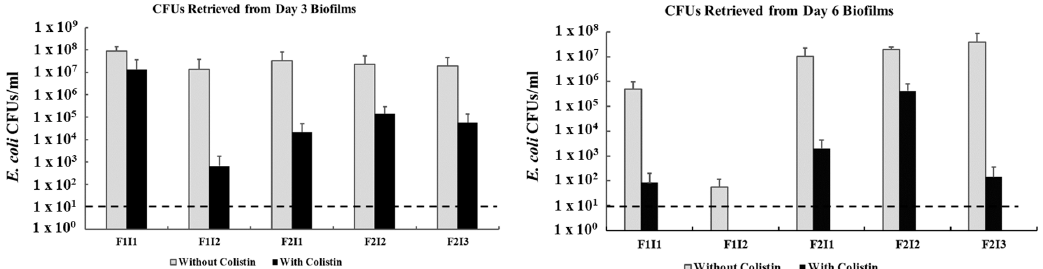
Figure 2. The persistence of mcr-1 - positive E. coli in 3- and 6 days old biofilms. The grey and black colors designate CFUs retrieved on RAPID’ E. coli 2 agar plates without and with colistin (4 µ g / mL), respectively. The dashed line designates the detection limit of the assay.